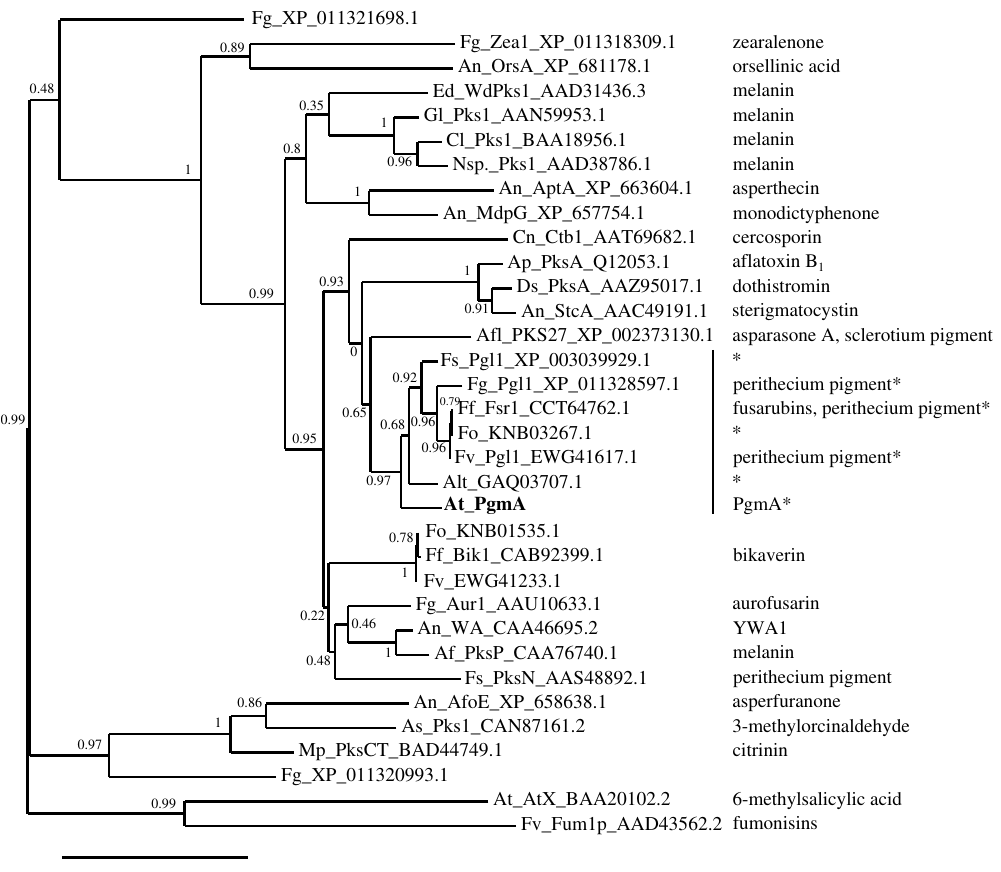
Figure 2. Phylogeny of different fungal polyketide synthases including pigment synthases. The range of polyketide synthases chosen for this analysis is based on a study of Studt et al. [37]. The extracted ketoacyl synthase domains of the polyketide synthases were compared and aligned to obtain a phylogram as described in our related study [22]. The chemical product of the corresponding polyketide synthase (PKS) is given on the right side if characterised, to our knowledge. The scale bar represents a 0.4 residue change per site. No outgroup was used. The organisms used in the